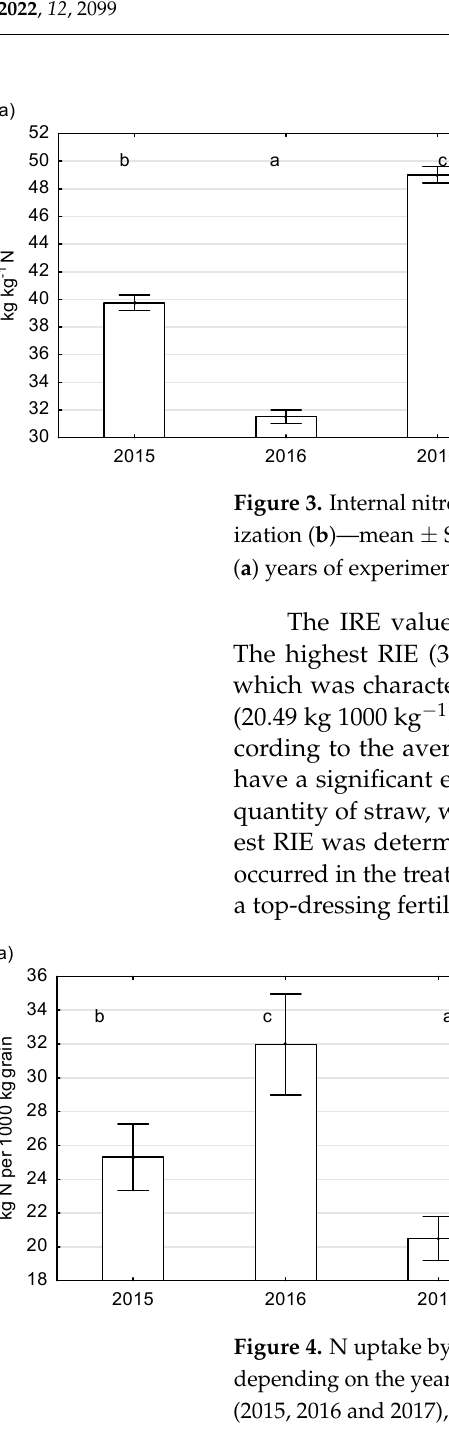
kg kg − 1 N. Variable weather conditions, and hence different maize yields in the particular research years, rendered the observed differences statistically insignificant.